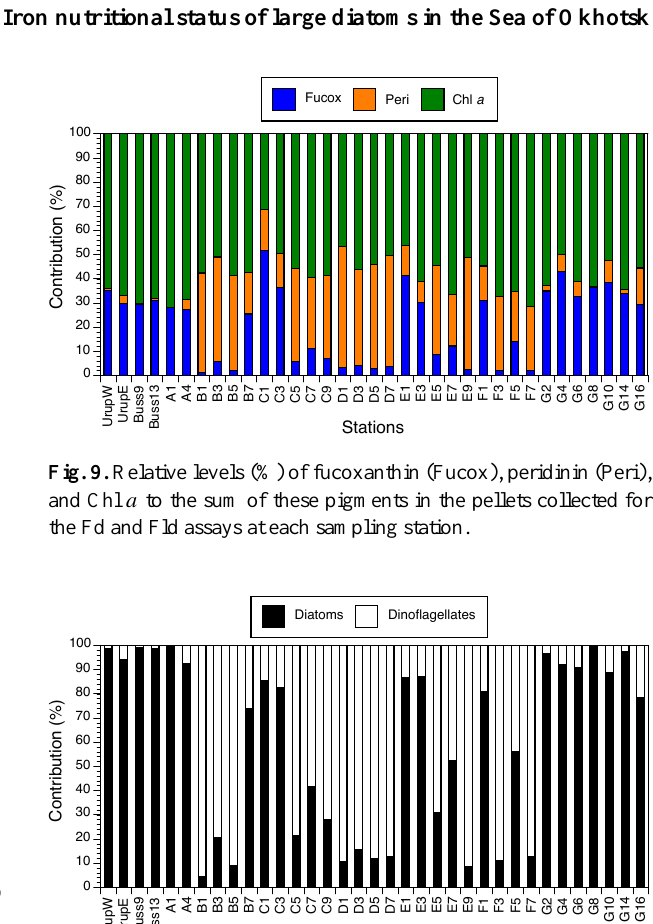
Fig. 8. Relationships between dissolved iron (D-Fe) concentrations (nM) and (a) the Fd index values for micro-sized diatoms or (b) F v / F m values for total micro-sized phytoplankton in surface wa- ters off Sakhalin Island. The data obtained were fitted with the Michaelis–Menten equation (see the text).